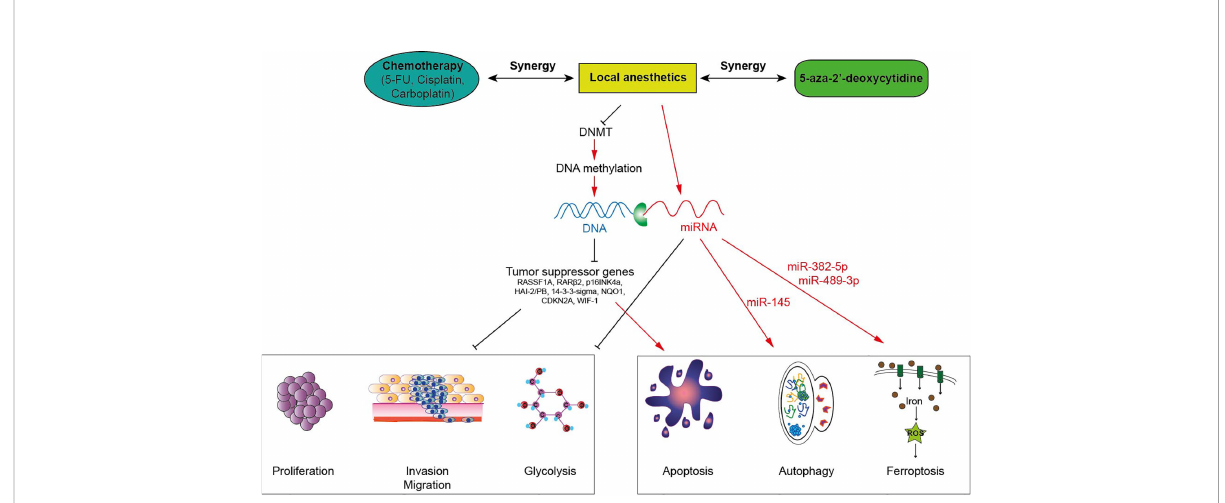
FIGURE 1 Local anesthetics induce anti-tumor effects via epigenetic modulation in cancer cells. Local anesthetics inhibit DNA methyltransferases (DNMT) decreasing the level of DNA methylation. This hypomethylation (or demethylation) restores the expression of various tumor suppressor genes impeding the proliferation, the invasion and the mitochondrial metabolism of tumor cells. This epigenetic effect of local anesthetics potentiates the cytotoxic activity of antineoplastic